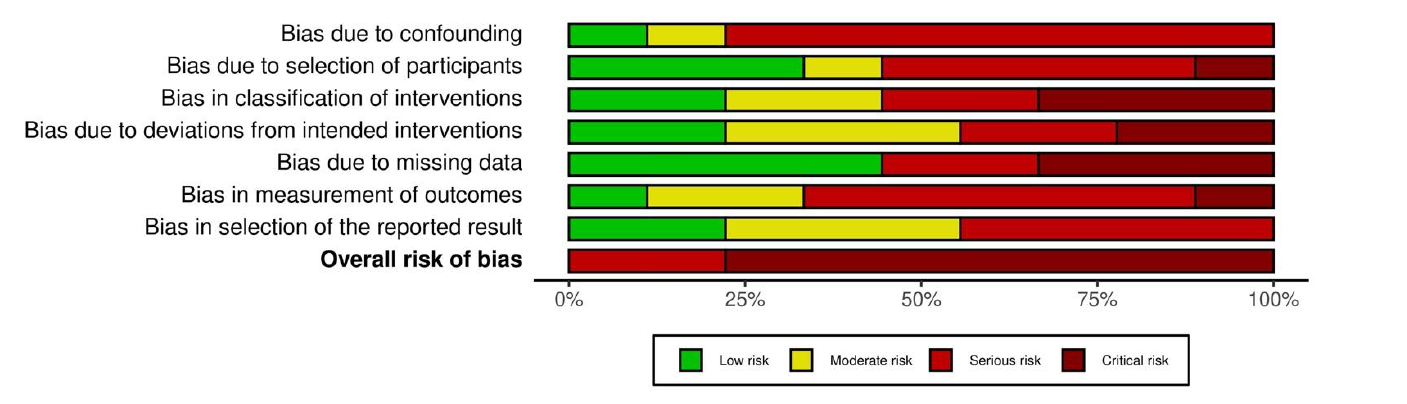
Figure 3 ROBINS-I Weighted Summary Plot bias assessment. Figure 3. ROBINS-I Weighted Summary Plot bias